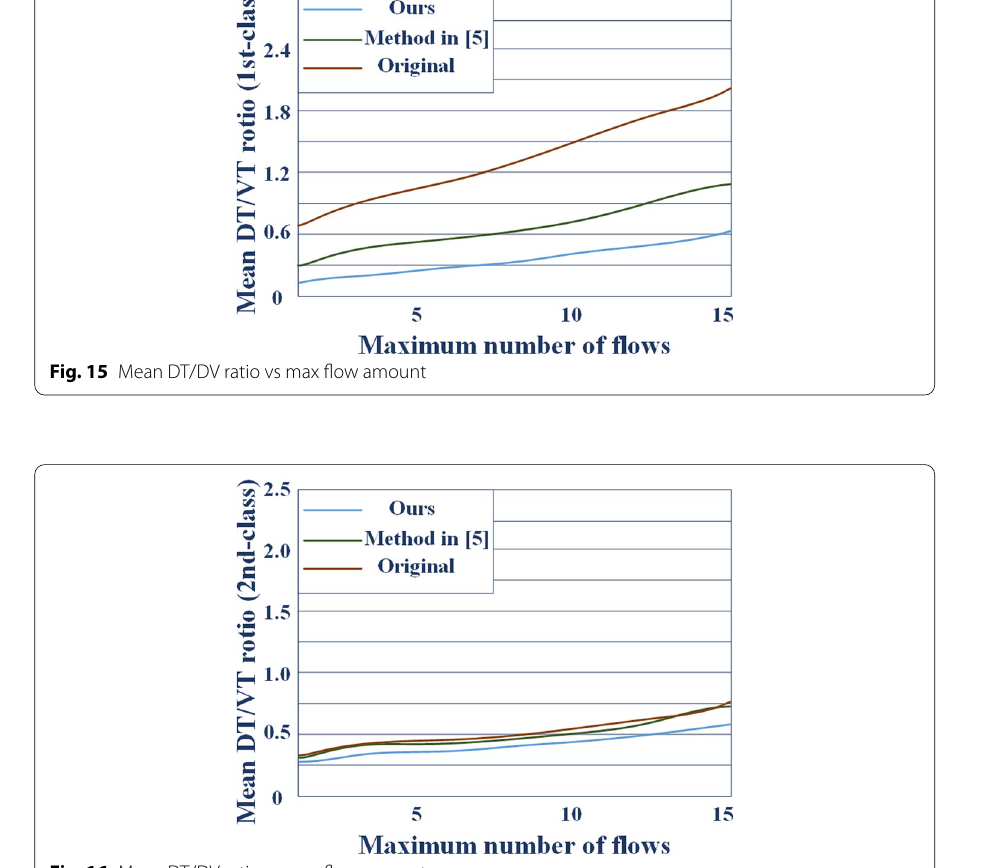
Fig. 16 Mean DT/DV ratio vs max flow